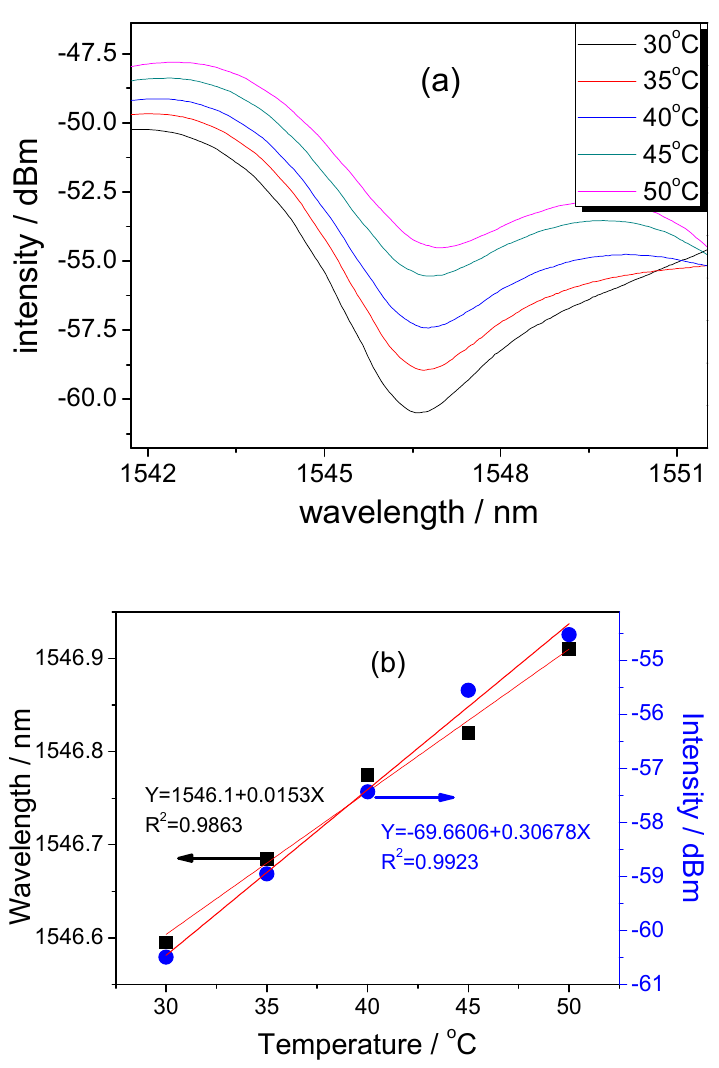
Figure 6. ( a ) Shift of interfered fringe with varied temperature and ( b ) the corresponding sensitivity and linearity of wavelength and intensity.